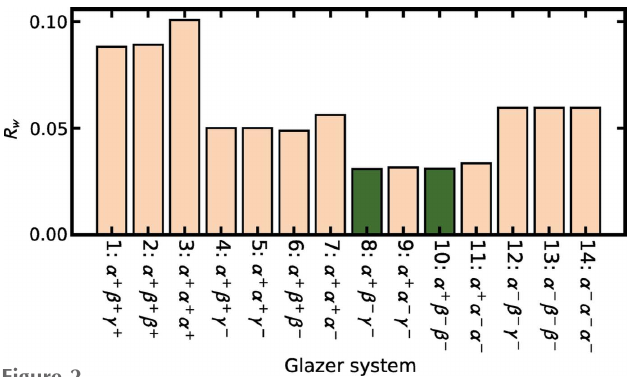
Figure 2 Comparison of the fit of the 14 three-tilt Glazer systems to a simulated PDF of CaTiO 3 with octahedral rotations but without Ca displacements.